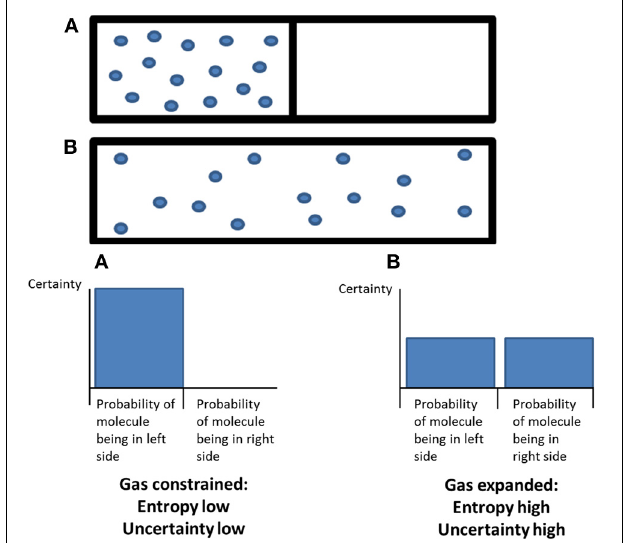
FIGURE 8 | Gas expansion post-release of constraints as a metaphor for increased entropy in primary states. (A) Entropy is low while the gas is constrained. (B) Entropy increases once constraints are released. In an information theoretical sense, entropy/uncertainty is increased post-expansion because it is more difficult to predict the spatial location of a single molecule. In primary vs. secondary states, it is hypothesized that the biological parameters known to define key brain states (e.g., the default-mode) become more variant or less predictable, thus causing the subject to become less certain in themselves and their experience of the